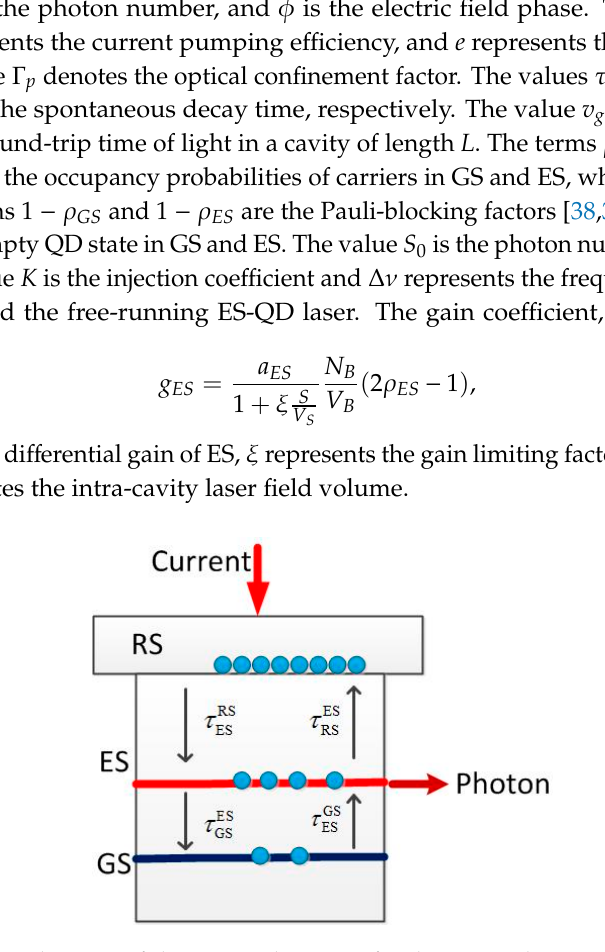
Figure 1. Schematic diagram of the carrier dynamics for the ES-QD lasers. GS: ground-state; ES: excited-state; RS: reservoir.